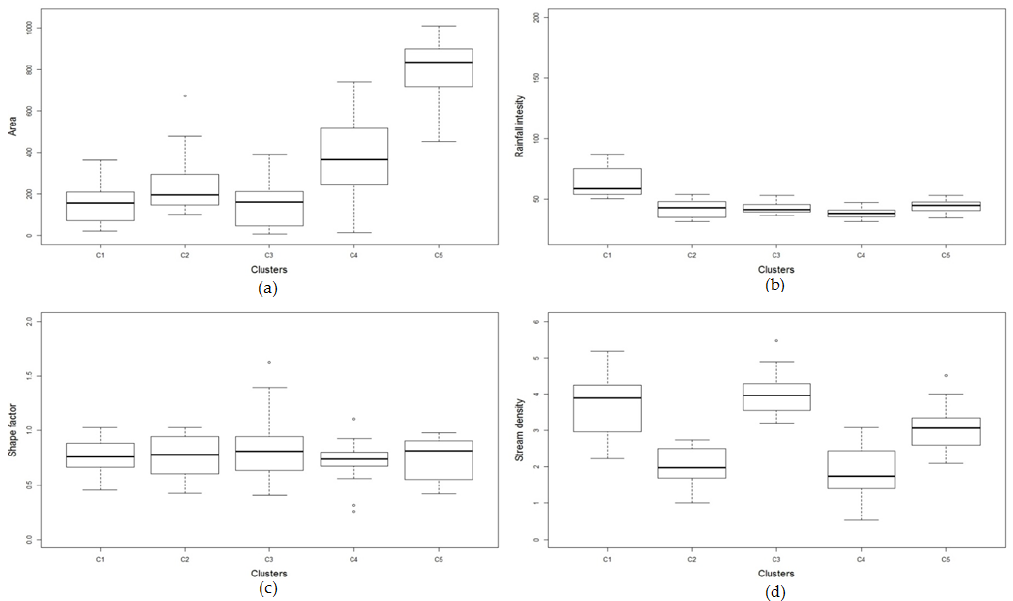
Figure 7. Boxplots of area, rainfall intensity, shape factor and stream density for all clusters: (a) boxplot of area; (b) boxplot of rainfall intensity; (c) boxplot of shape factor; and (d) boxplot of stream density.